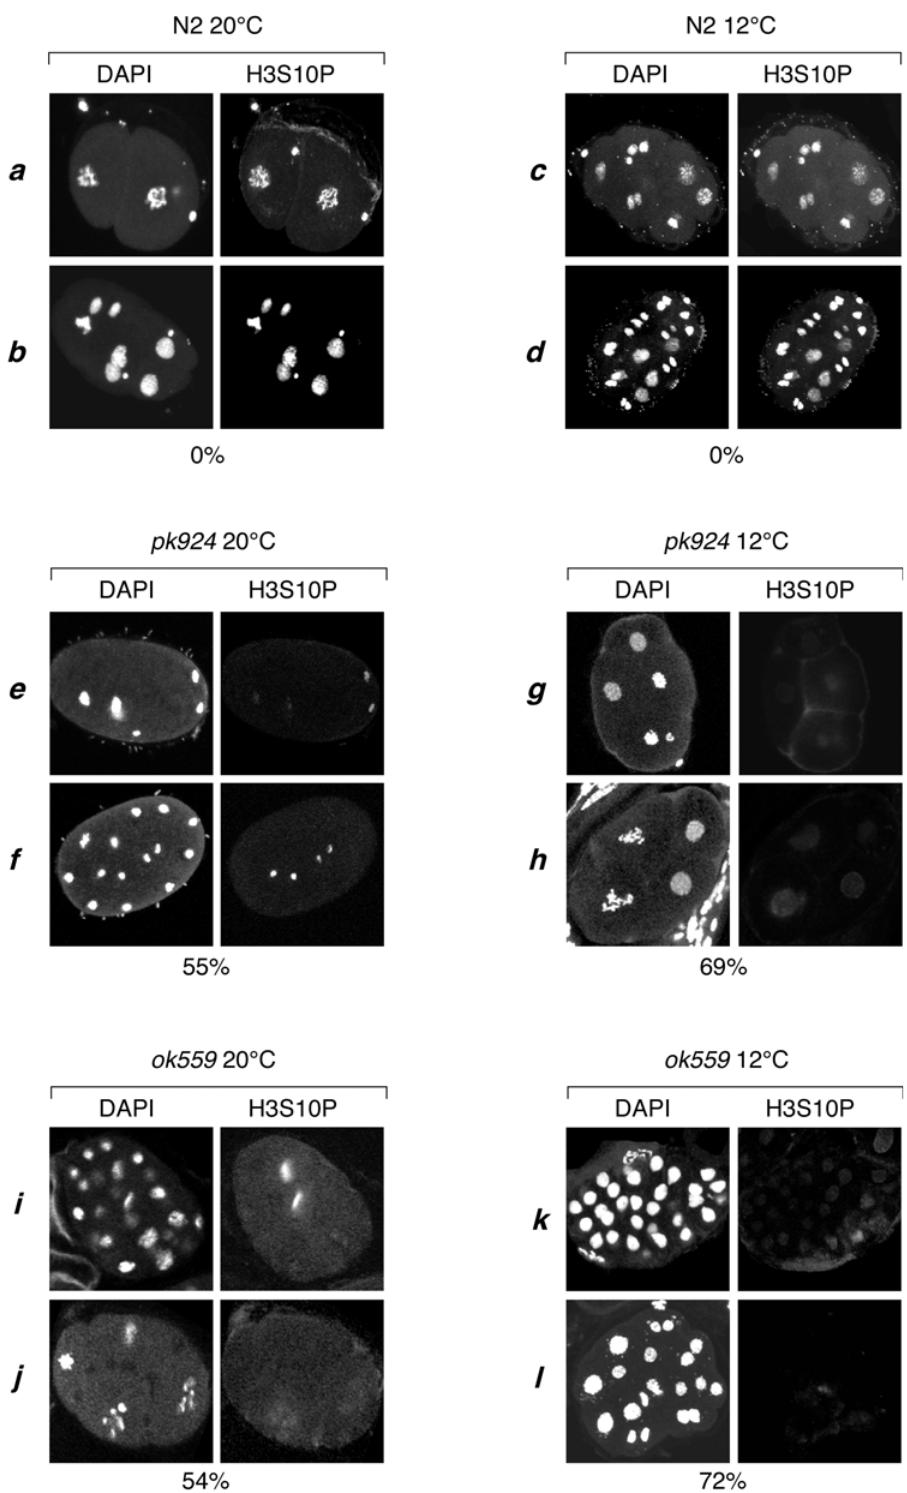
Figure 6.hcf-1mutant embryos display a reduced staining of H3S10P. The nuclei of wild-type N2, pk924 , and ok559 embryos collected from worms grown at either 20 u C (panels a, b, e, f, i, j) or 12 u C (panels c, d, g, h, k, l) were stained with DAPI (left) and anti-H3S10P antibody (right). The percentages of N2, pk924 , and ok559 embryos displaying reduced H3S10P staining at 12 u C and 20 u C are indicated below for each condition. The percentages for mutant worms were determined with the following sample sizes: N2 at 20 u C, n . 150; pk924 at 20 u C, n=141; ok559 at 20 u C, n=140; N2 at 12 u C, n . 150; pk924 at 12 u C, n=150; and ok559 at 12 u C, n=189, where n is the total number of embryos observed.